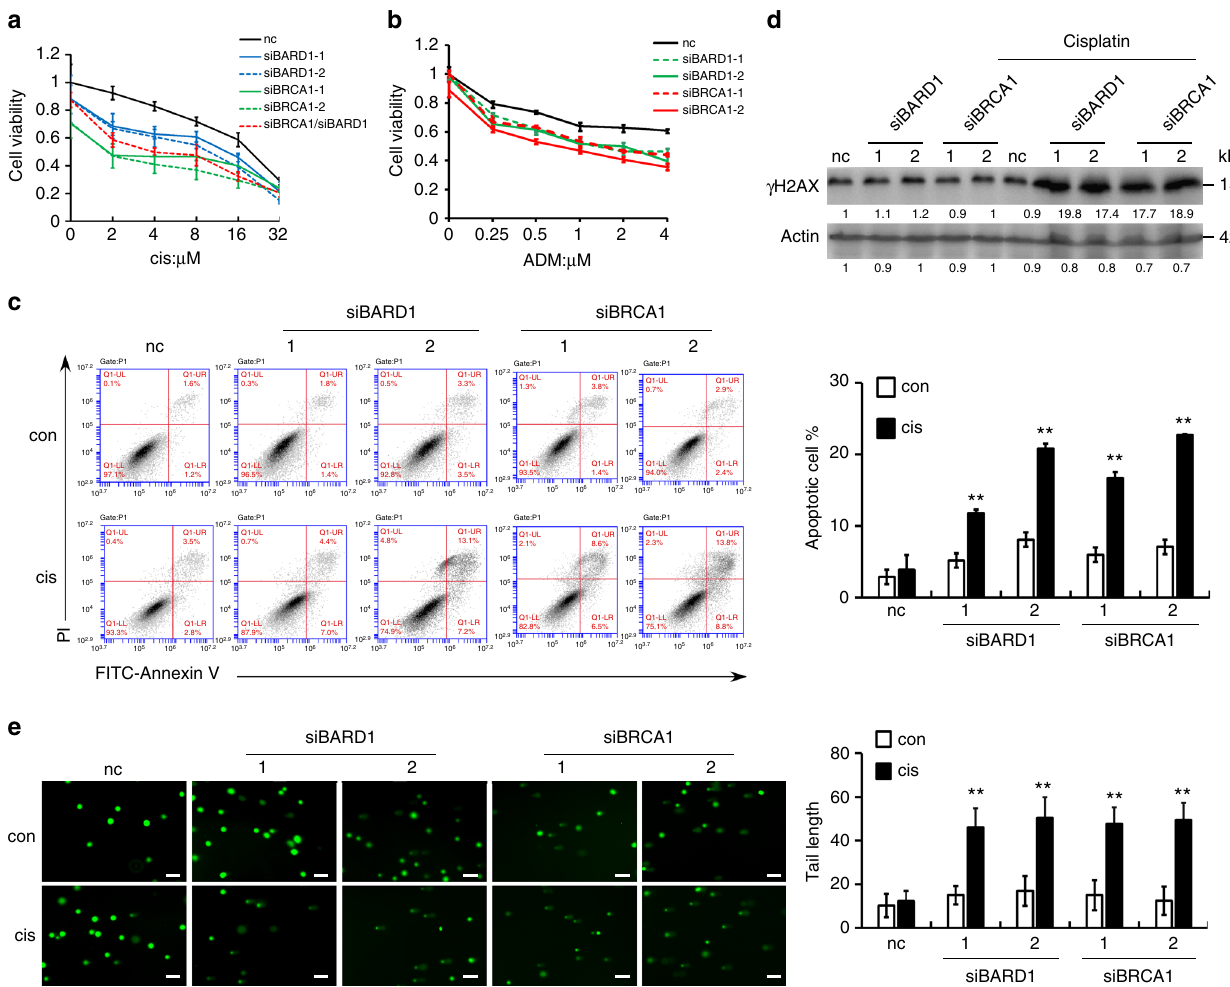
Fig. 3 Reduced BARD1 or BRCA1 expression sensitizes tamoxifen-resistant cells to cisplatin. MCF7-Re cells were transfected with negative control siRNA (nc), BARD1, and/or BRCA1 siRNAs. a , b Cell viability assay showing the sensitivity to cisplatin ( a ) and ADM ( b ). c Apoptosis assay by AnnexinV-FITC/PI staining showing the effect of cisplatin on the percentages of apoptotic cells. d The expression of γ H2AX induced by cisplatin. e Comet assay showing the DNA damage induced by cisplatin. Scale bar indicated 100 μ m. In a – c , e , data show means±s.d. ( n = 3) ** p <0.01 compared with control by Student ’ s t